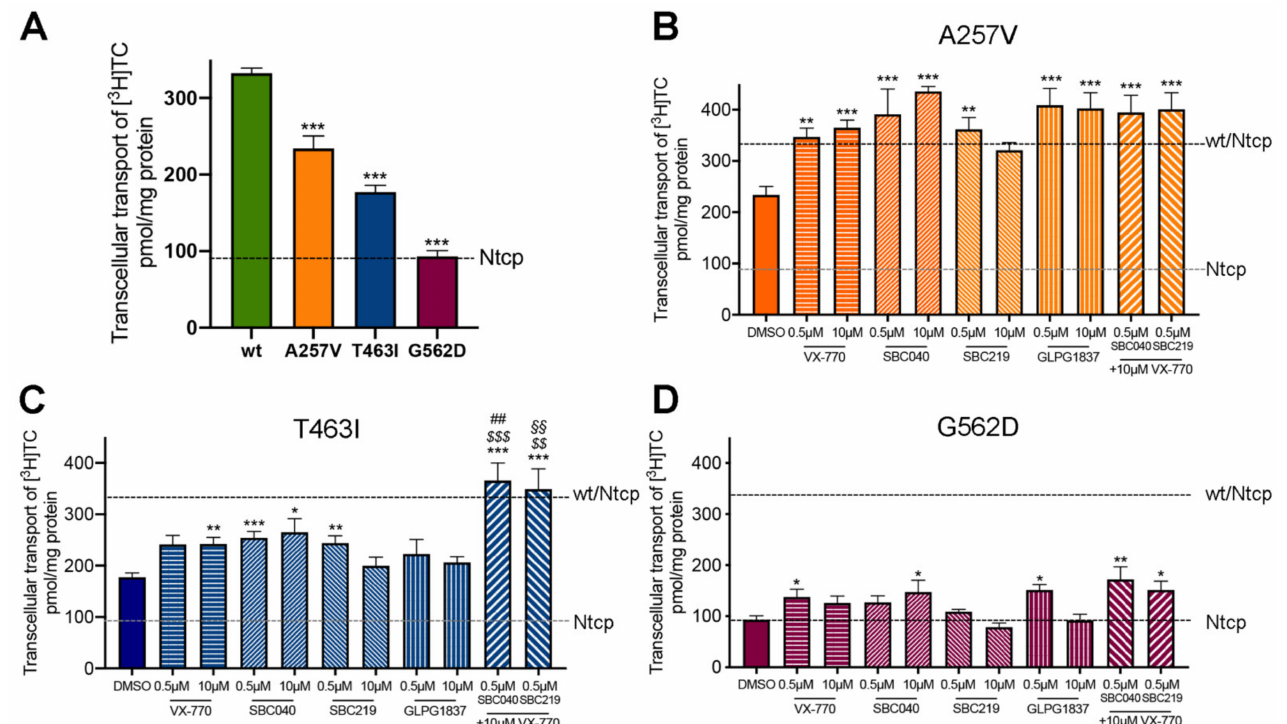
Figure 5. CFTR potentiators totally or partially rescue the functional defect of Abcb11 variants. ( A – D ) Vectorial transport of [ 3 H]TC in MDCK cells stably expressing Abcb11-GFP (wt or variants) and Ntcp in the absence ( A ) or presence of the indicated concentrations of ivacaftor, GLPG1837, SBC040 or SBC219 in the A257V ( B ), T463I ( C ) or G562D ( D ) variants of Abcb11-GFP. The upper and lower dashed lines indicate [ 3 H]TC transport measured in MDCK cells expressing both wt and Ntcp or Ntcp alone, respectively. Means ( ± SEM) of at least six independent experiments for each tested condition are shown. * p < 0.05; ** p < 0.01; *** p < 0.005 vs. non-treated Abcb11-wt-GFP expressing cells (panel A); $$ p < 0.01; $$$ p < 0.005 vs. VX 770-treated cells; ## p < 0.01 vs. SBC040-treated cells; §§ p < 0.01 vs. SBC219-treated